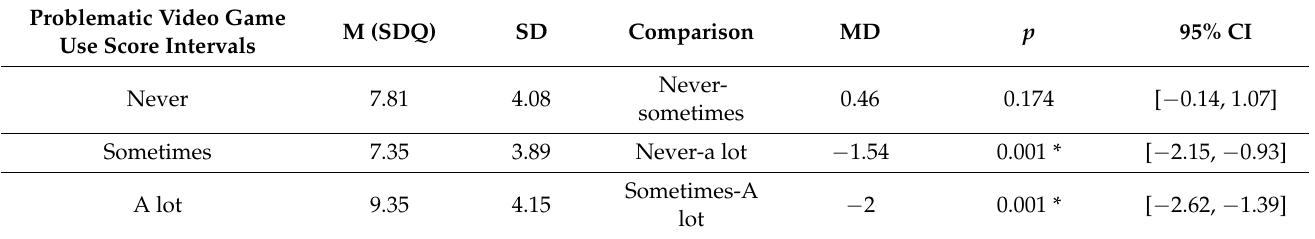
Table 2. SDQ means and means comparison by video game use.